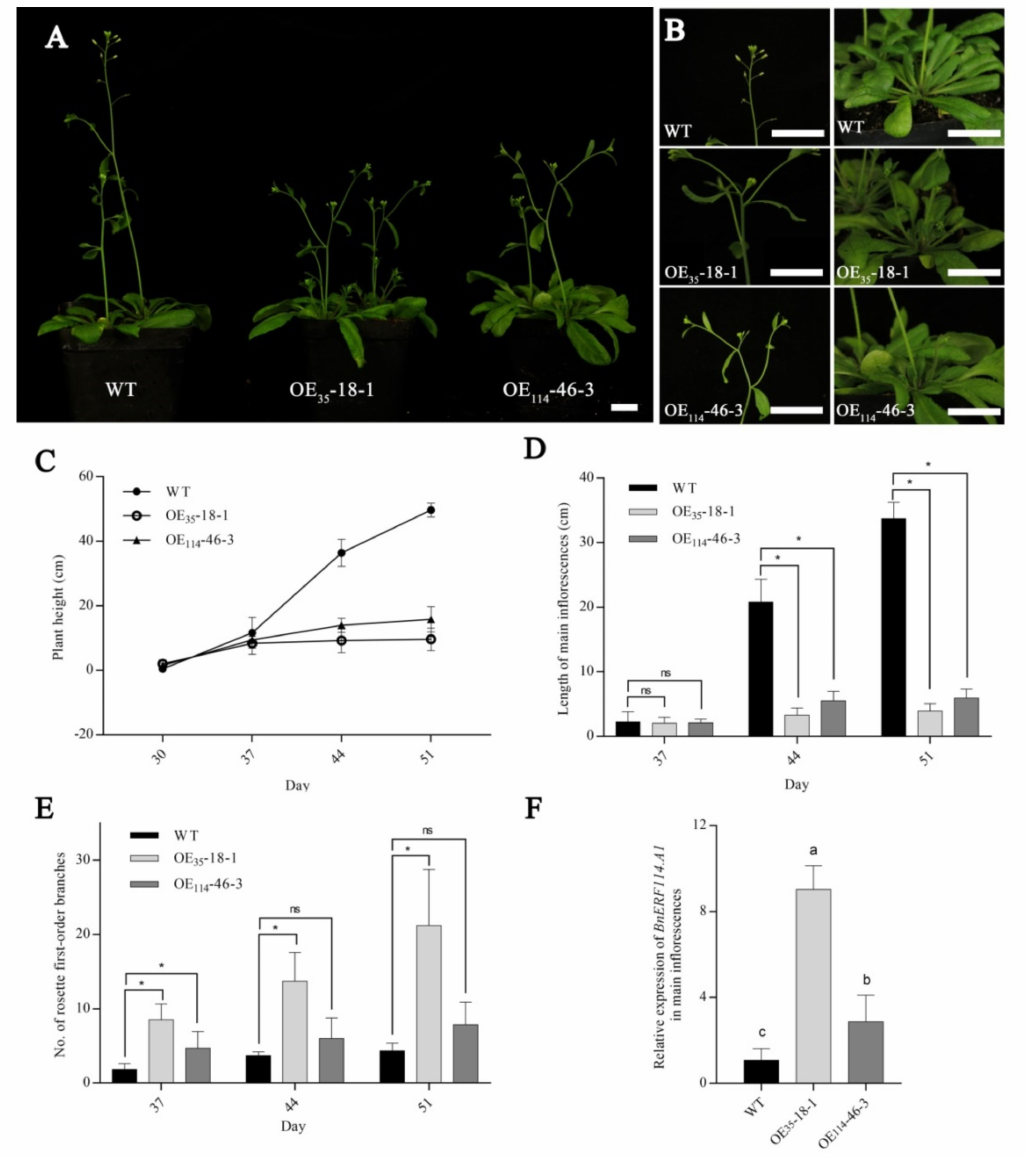
Figure 5. Effects of BnERF114.A1 ectopic expression on plant phenotype. WT, wild-type (Col-0) Arabidopsis ; OE 35 -18-1, transgenic line expressing BnERF114.A1-eGFP-GUS under the 35S promoter; OE 114 -46-3, transgenic line expressing BnERF114.A1-GUS under the 114pro promoter. ( A ) pheno- types of OE 35 -18-1 and OE 114 -46-3 transgenic plants at 40 days old. ( B ) phenotypes of the main inflorescence and first rosette branches of OE 35 -18-1 and OE 114 -46-3 transgenic plants at 40 days old, in ( A , B ) Bars = 2 cm. ( C ) plant height of OE 35 -18-1 and OE 114 -46-3 transgenic lines at 30, 37, 44, and 51 days, each point represents mean ± SD of 5–10 independent individuals. ( D ) length of the main inflorescence in OE 35 -18-1 and OE 114 -46-3 transgenic lines at 37, 44, and 51 days; each column represents mean ± SD of 5–10 independent individuals. ( E ) number of first rosette branches in OE 35 - 18-1 and OE 114 -46-3 transgenic lines at 37, 44, and 51 days. In ( D , E ), asterisks indicate significant differences at the p = 0.05 level, and “ns” indicates non-significant differences at the p = 0.05 level. ( F ) relative BnERF114.A1 expression in the main inflorescence of OE 35 -18-1 and OE 114 -46-3 plants at 40 days old; gene expression levels were normalised to the reference gene AtUBC21 ( At5g25760 ); each column represents mean ± SD from three independent biological replicates, and each biological replicate included five individuals. Different lowercase letters indicate significant differences at the p = 0.05